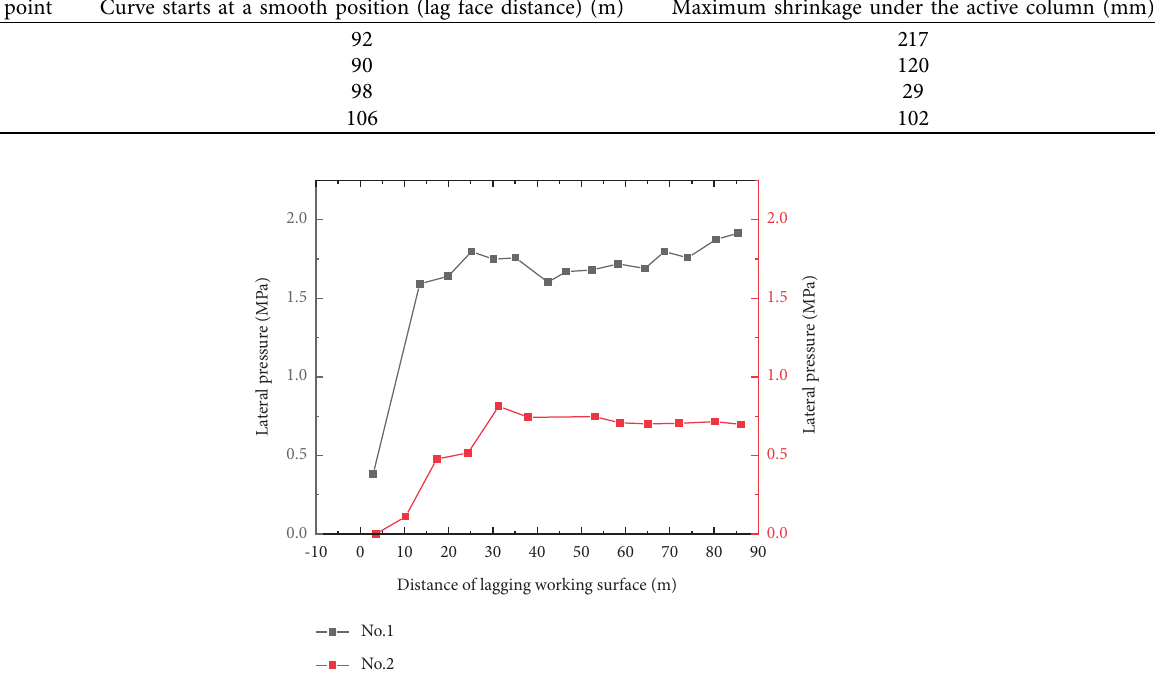
Figure 10: Variation curve of lateral pressure at the monitoring points. Table 7: Comparison of surface subsidence and